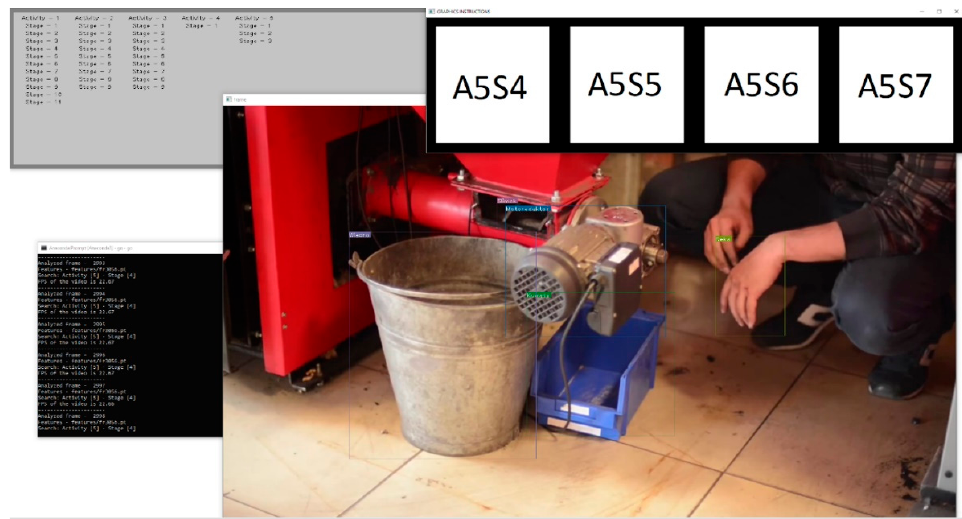
Figure 3. Sample of the system interfaces demonstrating various functionalities.